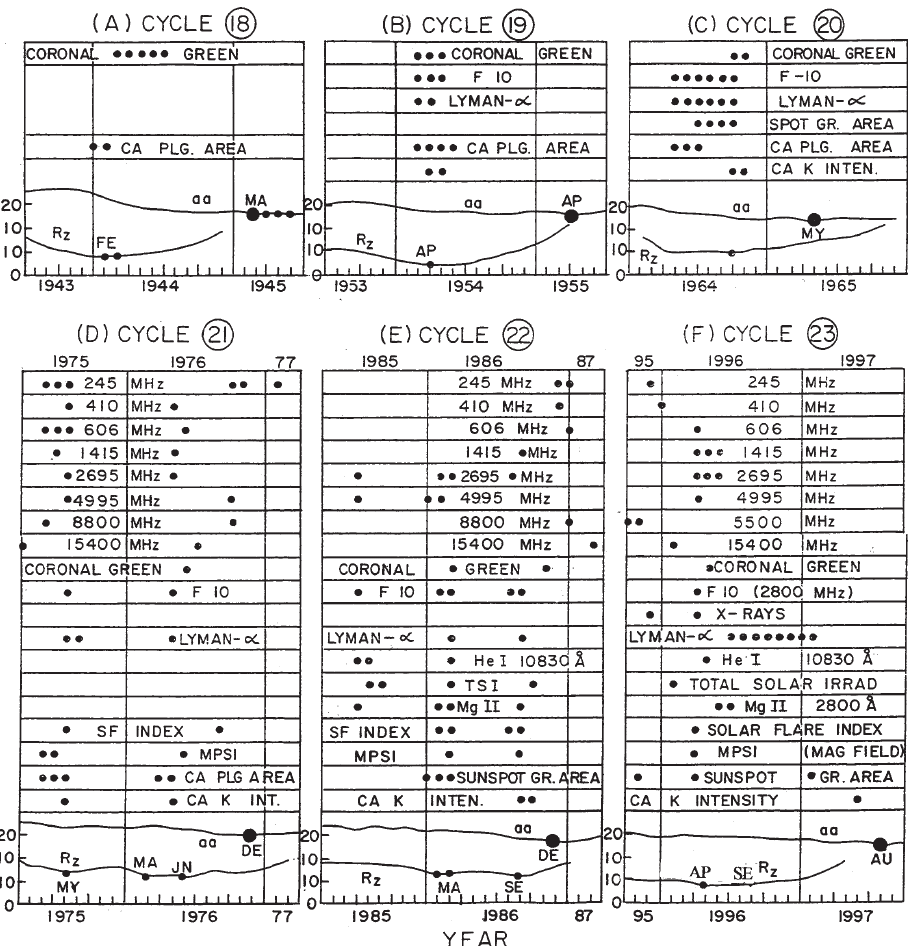
Fig. 2. Plots of the 12-month moving averages of Rz and aa during years of sunspot minima of (A) cycle 18, 1943–1945, (B) cycle 19, only the months of minima are indicated by full dots. The aa (min) is indicated by a bigger full